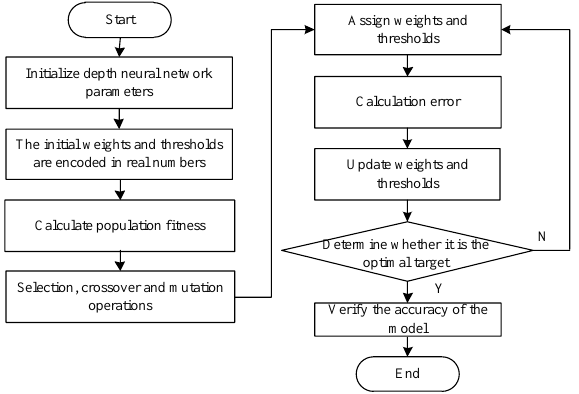
Figure 3. Training process of deep neural network In the process of training a deep neural network, the samples are passed down layer by layer, and the error is calculated from the bottom to the top, and finally solved in a recursive way [10]. The weights and thresholds are updated using the calculated error values, and the global optimal solution is obtained after the model is continuously converged. Due to the differences in the temperature sensor samples in different regions, there are usually several orders of magnitude difference in each parameter. The more specific the function, the higher the priority. In the case of accurate matching, the transformed parameters have the same priority as the accurately matched parameters. Therefore, this paper selects premnmx function as the preprocessing function to normalize the input layer data, so as to improve the network performance and network training efficiency. The Figure 2. Deep neural networks structure normalization calculation formula of premnmx function is as follows: A deep neural network consists of an input layer, a g g , hidden layer, and an output layer. Among them, k j g represent the thresholds of the input layer, hidden and l w w and w , layer, and output layer, respectively; k l j k ij represent the weights between the input layer, the hidden In formula (5),  and  represent the normalized z and z z , layer, and the output layer, respectively. values of the input and output samples, respectively; c k l j and represent the input and output samples, are used to represent the input, weight and threshold respectively; max and min represent the calculation result of each layer node, respectively. The